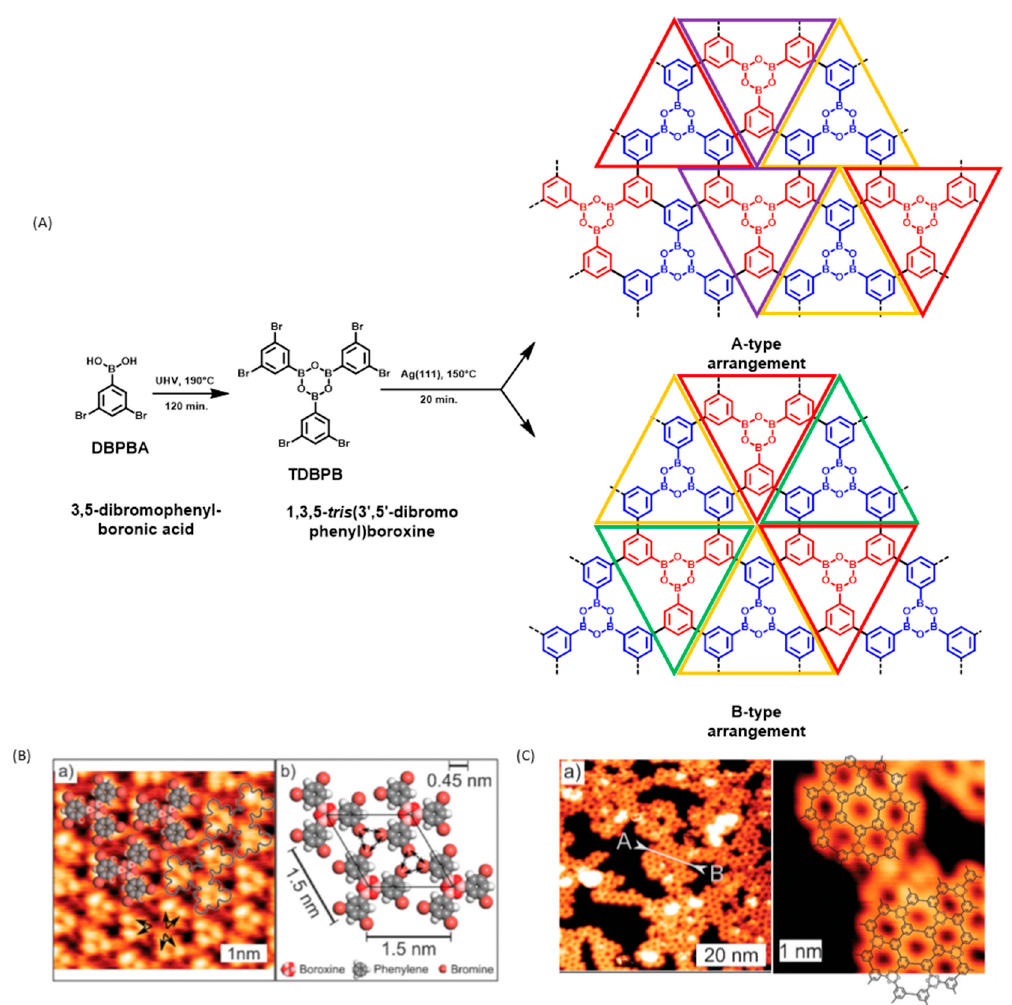
Figure 11. Reactions involved in the polymerization process of 3,5-dibromophenylboronic acid (DBPBA). ( A ) The two potential A- and B-type arrangements. ( B ) STM topograph of the supramolecular phase on Ag(111) obtained with 1,3,5- tris (3’,5’-dibromophenyl)boroxine (TDBPB) and the tentative model of the monolayer. ( C ) STM topographs of the polymer phase at different magnifications. Reproduced from [94] with permission from The Royal Society of Chemistry.